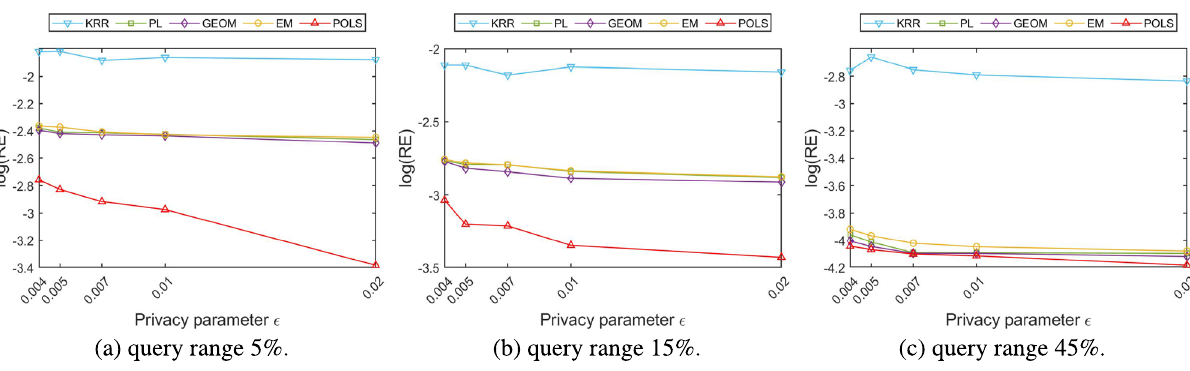
Figure 13. Comparison of range counting query accuracy (dataset with 500,000